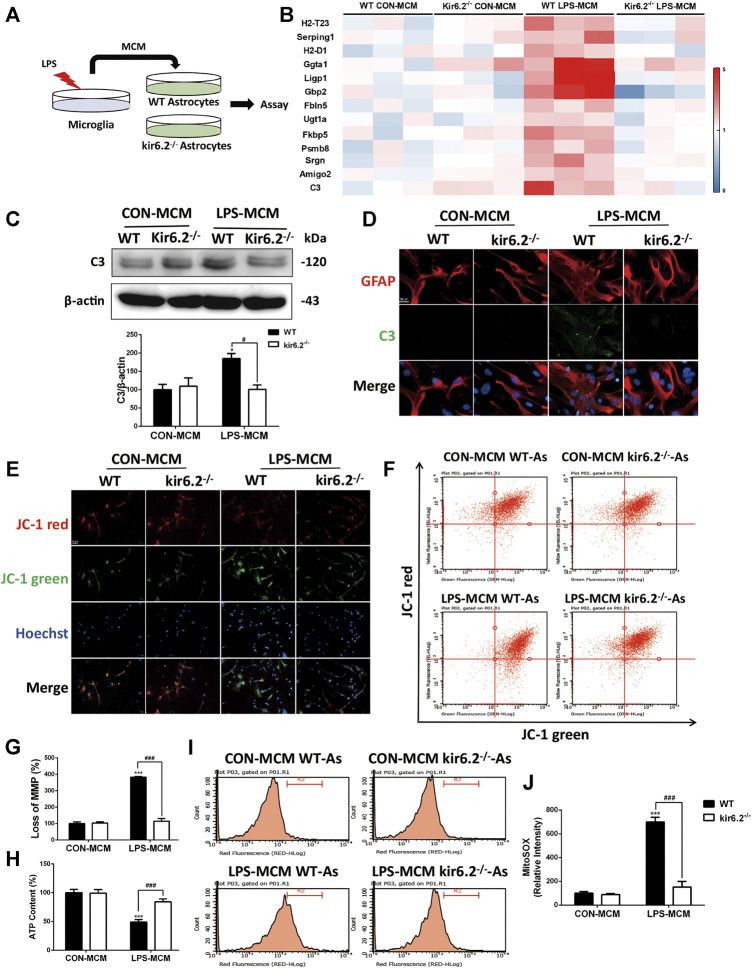
Kir6.2-deficient astrocytes are resistant to neurotoxic A1-like phenotype in vitro. (A) Protocol of treatment for B-J. Primary microglia from WT mice were stimulated with 100 ng/ml LPS for 24 h to collect the MCM. For primary astrocytes cultures, the MCM was diluted at a ratio of 1:3 to incubate the primary astrocytes from WT and kir6.2−/− mice for 24 h. (B) Heat map comparing the mean expression of A1-specific transcripts in astrocytic RNA samples by RT-PCR. (C) Expression of C3 in the midbrain were detected by western blotting and its densitometric analysis. (D) Immunofluorescent stainings of C3 (green) and GFAP (red) in primary astrocytes. (E) Representative images of JC-1 stain in astrocytes were observed by confocal microscopy. Hoechst stains nucleus (blue). (F) Flow cytometric analysis of astrocytes stained with JC-1 fluorescent probe. (G) Quantification of MMP loss in JC-1 staining measured by flow cytometry. (H) ATP contents of astrocytes were analyzed. (I) Astrocytes were stained with MitoSOX fluorescent probe and analyzed by flow cytometry. (J) Quantification of the mitochondrial ROS by MitoSOX staining. Data were analyzed using two-way ANOVA. *p < 0.05 and ***p < 0.001 vs. corresponding CON-MCM group. #
p < 0.05 and ###
p < 0.001 vs. WT LPS-MCM group. Values are presented as means ± SEM from three independent experiments.